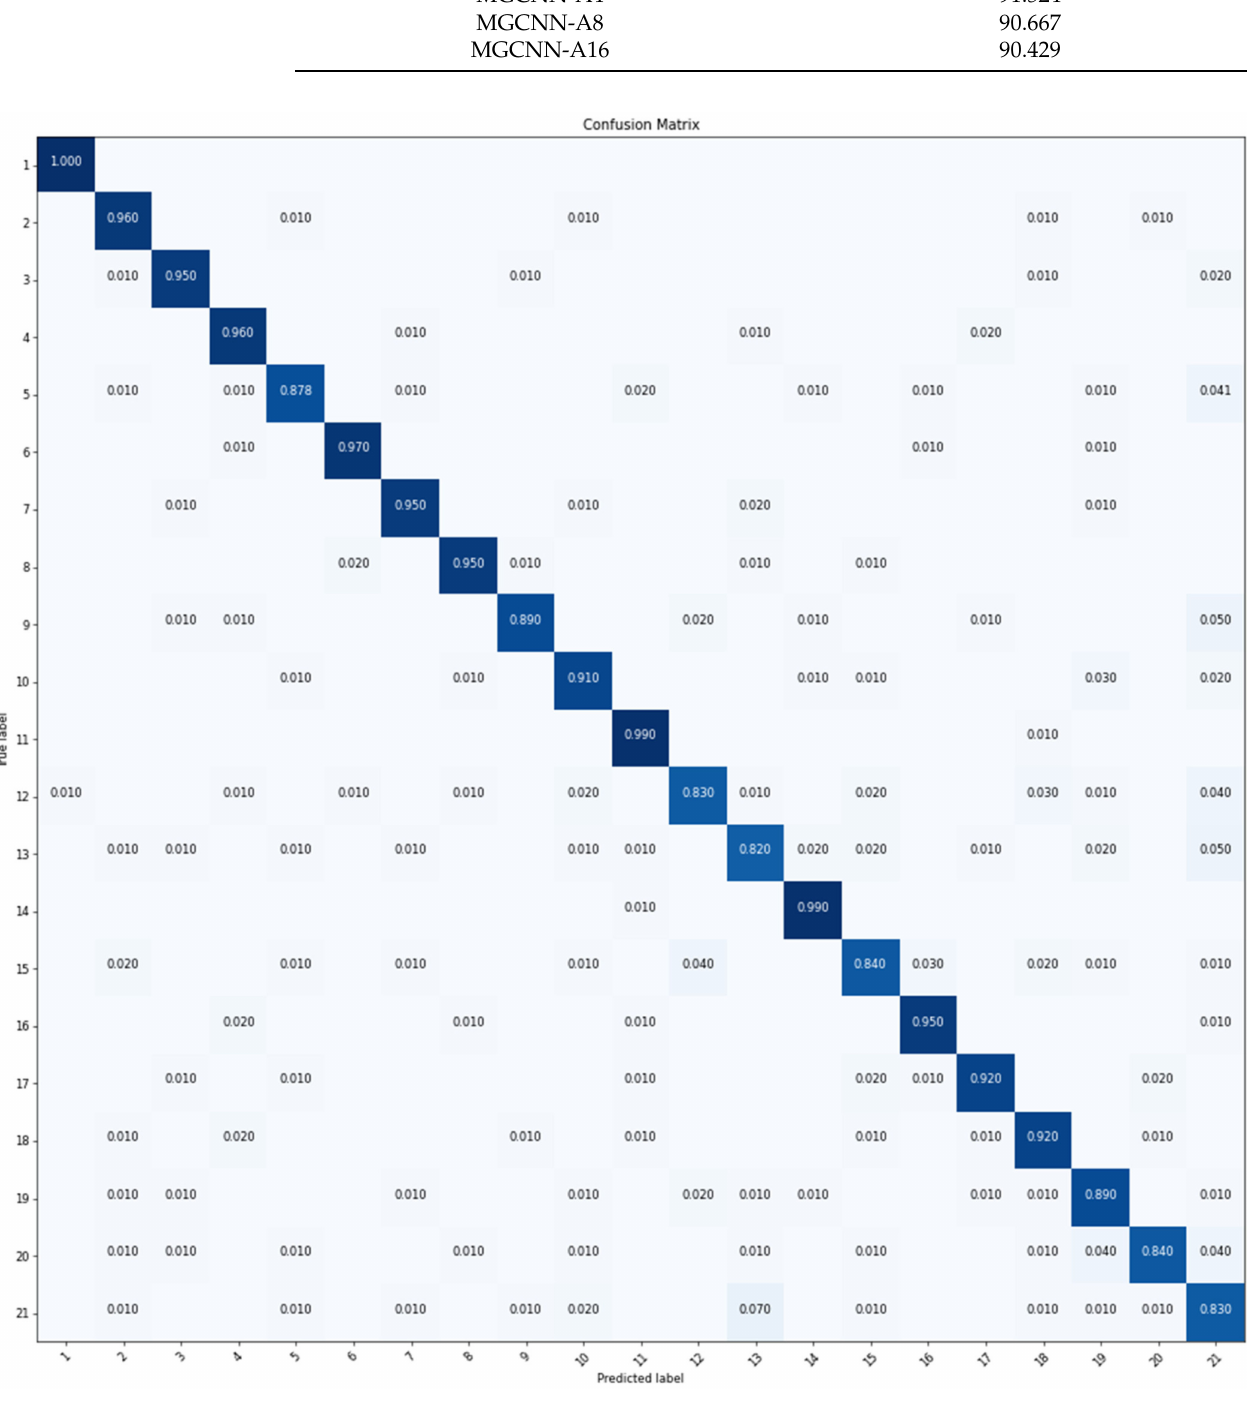
Figure 13. CM of MGCNN-A4 obtained with the UC-Merced